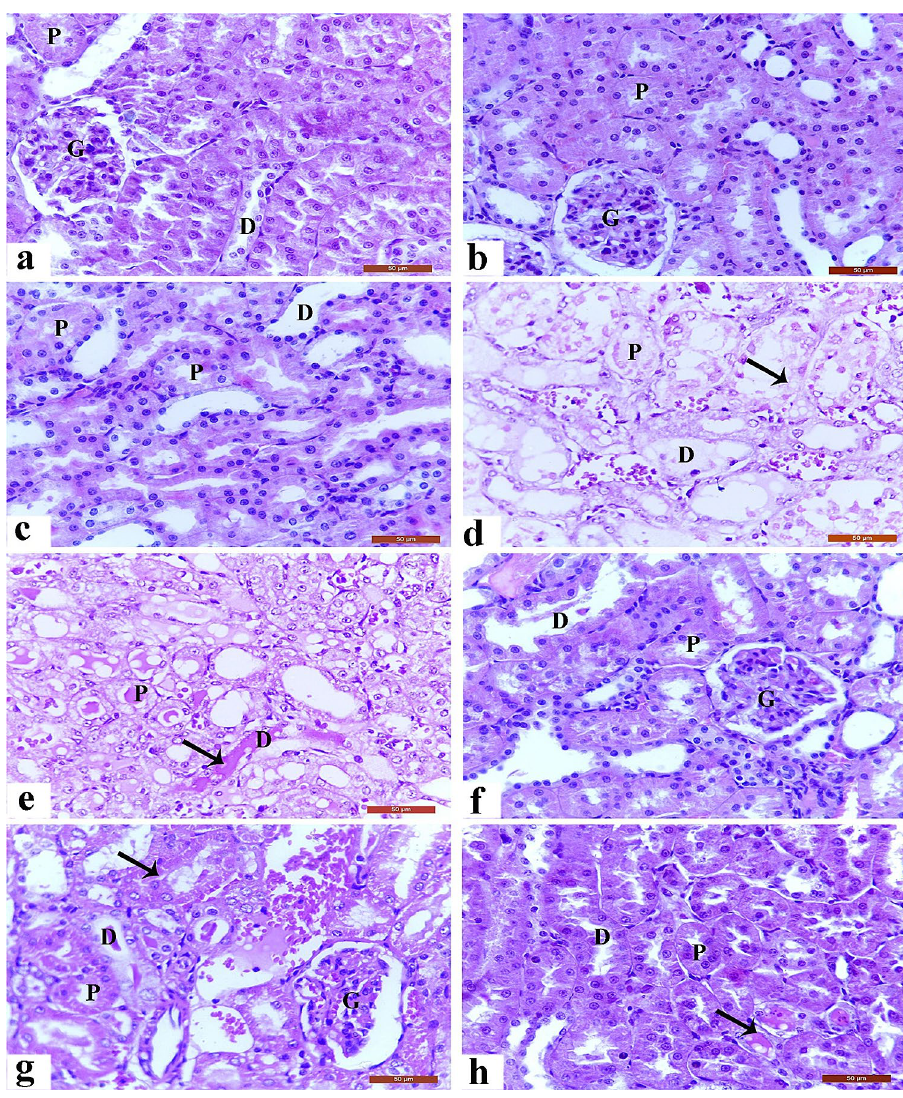
Figure 2. Histopathological changes in kidney sections. ( a )–( c ) Normal architecture of the renal cortex, renal corpuscle (arrow), glomerulus (G), proximal convoluted tubules (P), and distal convoluted tubules (D) in the control ( a ), LP ( 1b ), and NAC ( d ) groups. ( d ) CP-induced severe degenerative changes 1in the renal tubule epithelial lining ( f ), congested inter-renal blood vessels (I), hydropic degeneration (thin arrow), and pycnotic nuclei of epithelial cells (thick arrow). ( e ) CP-induced loss of normal architecture in the renal tubules, with hyaline cast materials in the lumen of most tubules (thick arrows), degranulated cytoplasm in some epithelial cells ( d ), and desquamated cells (thin arrow). ( f ) Histological changes in the kidney in the LP + CP group. Moderate effects in the renal tubules and degenerated and sloughed epithelial cells (thick arrow). ( g ) Histological changes in the kidney in the NAC + CP group. Moderate effects include congested inter-renal blood vessels (C), hyaline cast materials in the lumen of some tubules (h), and necrosis in some epithelial cells ( e ). ( h ) Histological changes in the kidney in the LP + NAC + CP group. Mild effects include proteinaceous materials in the lumen of some tubules (thick arrows). Scale bar = 50